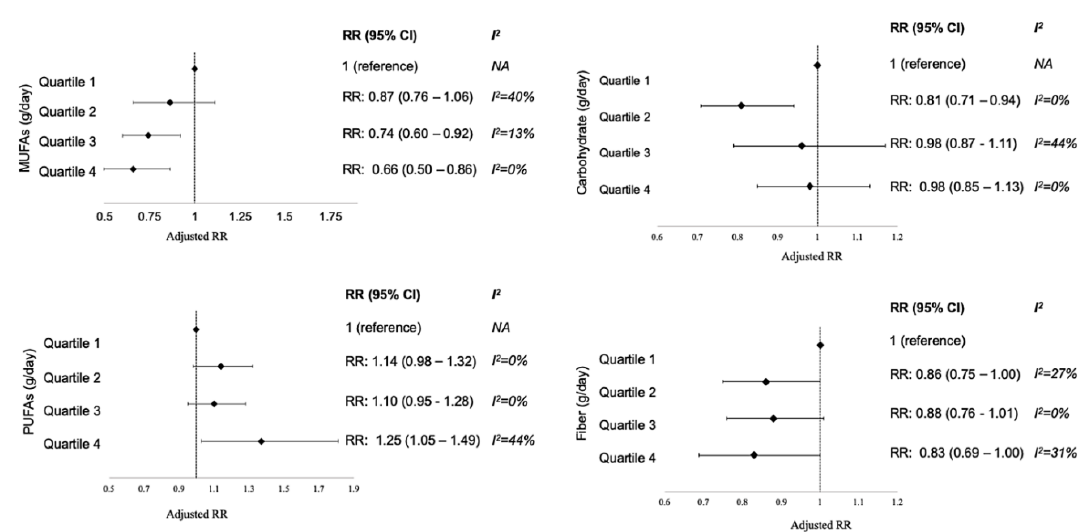
Figure 6. RR of menarche according to quartiles of MUFAs, PUFAs, carbohydrate, and fiber intakes among EMO and NEMO groups. Definition of abbreviations : CI, confidence interval; EMO, earlier menarche onset; MUFAs, monounsaturated fatty acids; NEMO, non-early menarche onset; PUFAs, polyunsaturated fatty acids; RR, risk ratio.